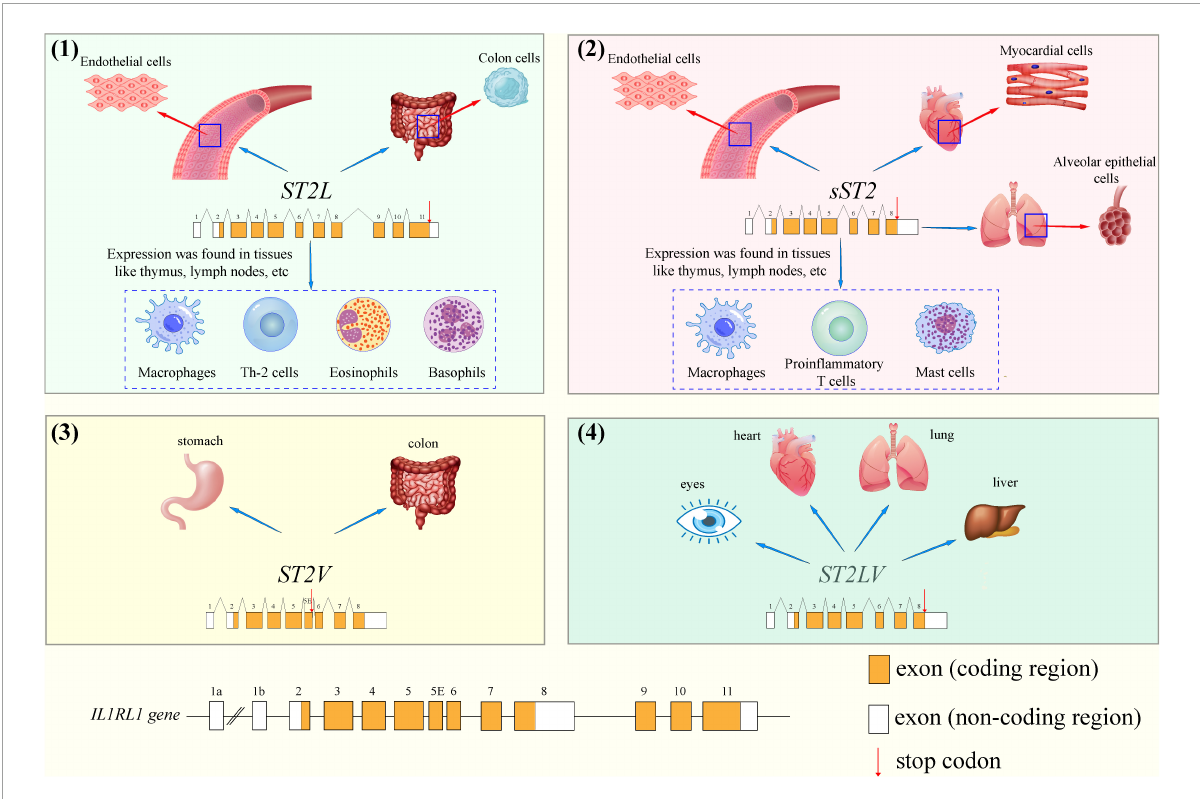
FIGURE1 The different gene structures of stimulation expressed gene 2 (ST2) isoforms and cellular localization: (1) ST2L, (2) sST2, (3) ST2V and (4)